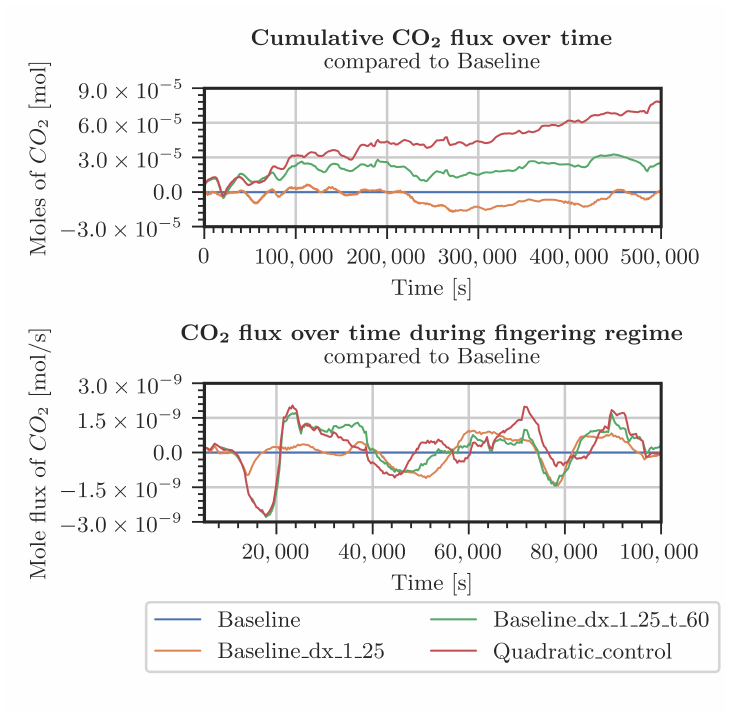
Figure A5. Difference in CO 2 entering the system for various grids (Table A1) with respect to the baseline grid. Measured pressure and CO 2 concentration at the top